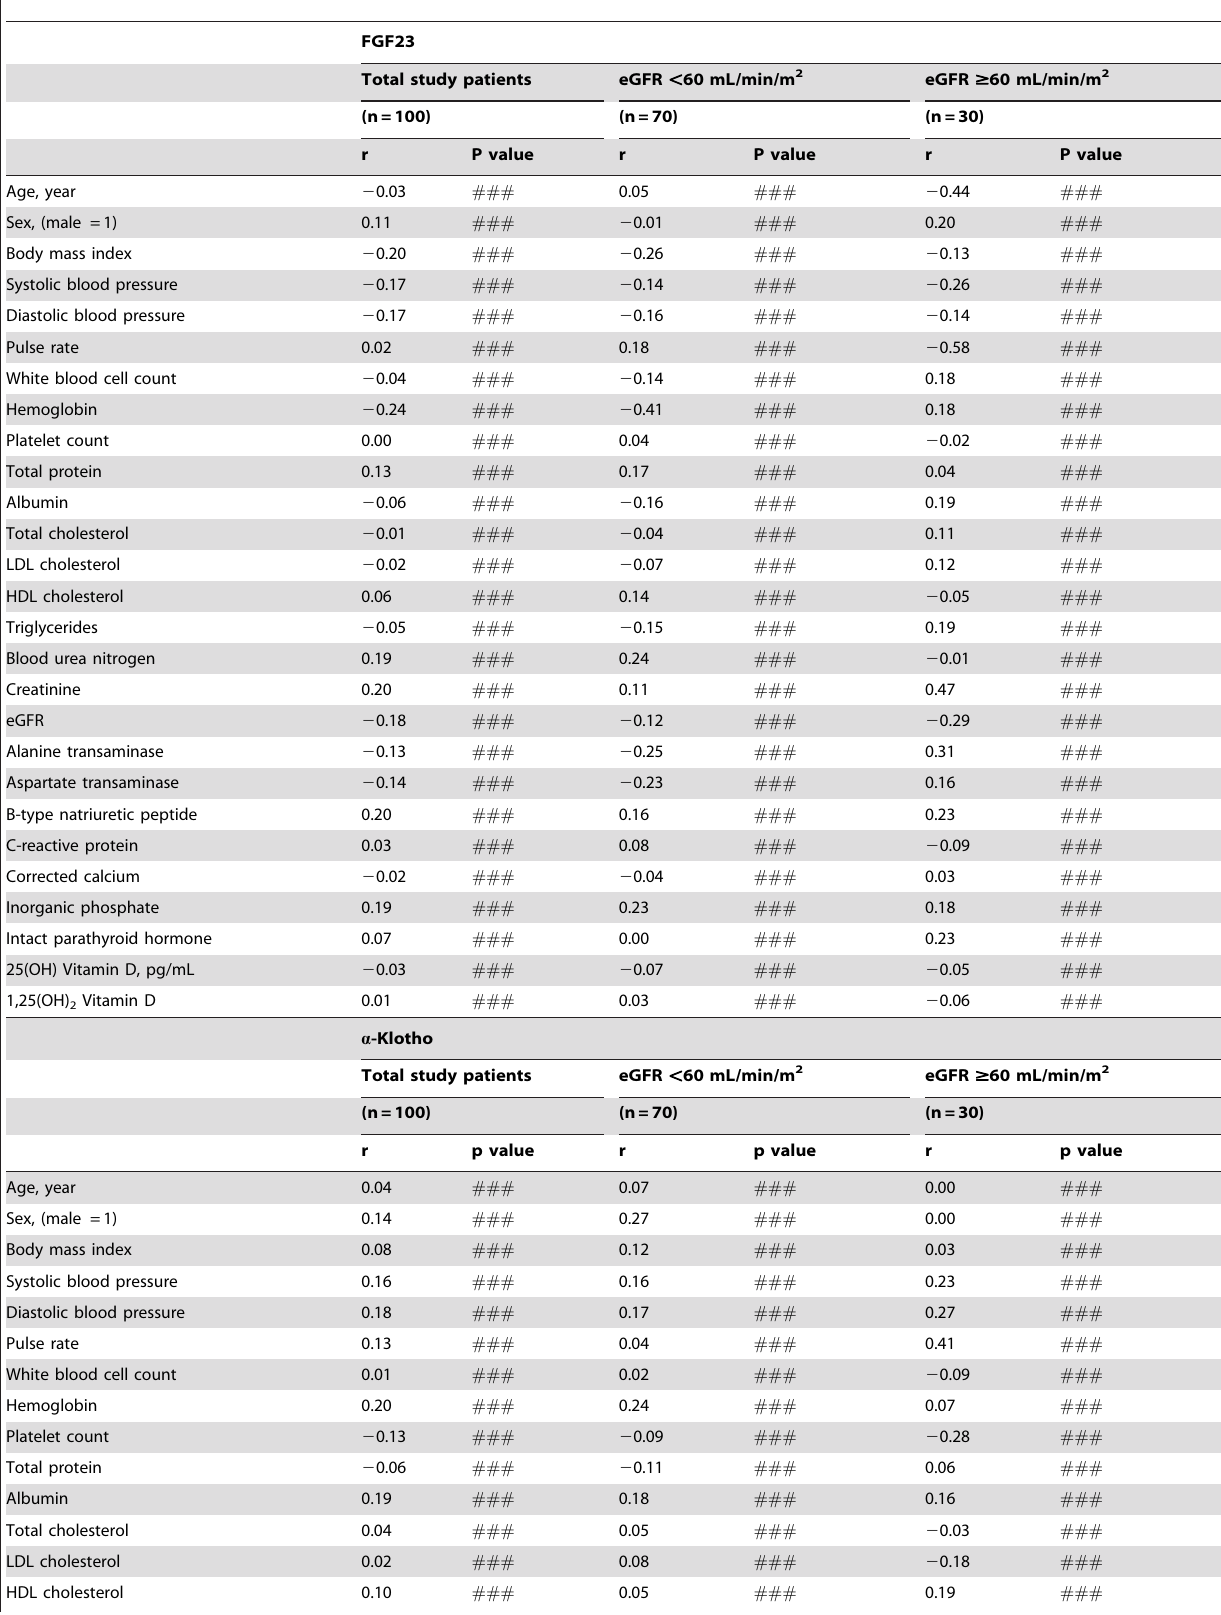
Table 3. Spearman’s correlation coefficients between FGF23 and various